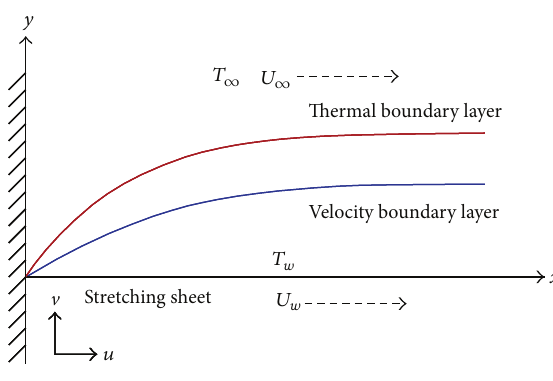
Figure 1: A diagram of the physical problem.